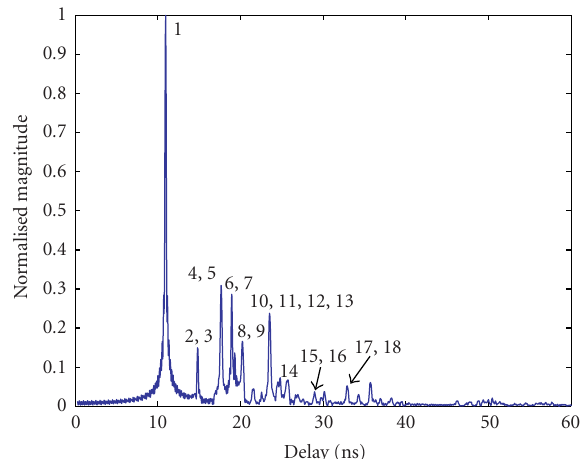
Figure 14: Impulse Response of the symmetric case described on Figure